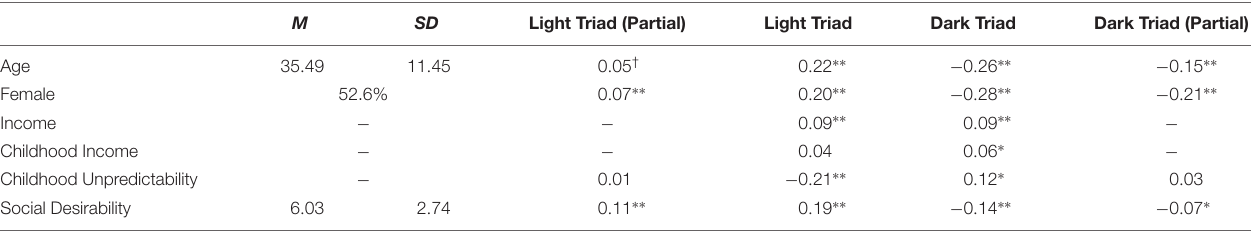
TABLE 5 | Correlations between demographic variables with light triad, dark triad, and light vs. dark triad. M SD Light Triad (Partial) Light Triad Dark Triad